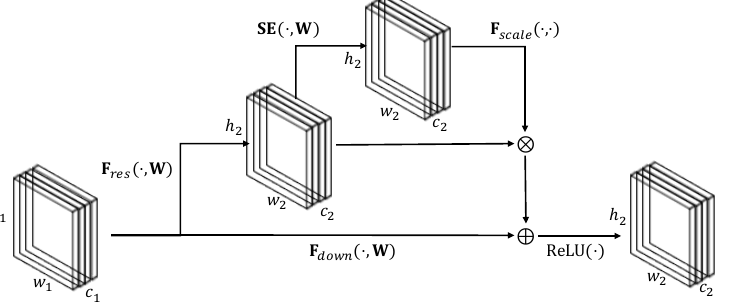
Figure 4. Residual Squeeze-and-Excitation block. After the residual block, the SE attention module is placed to weight enhance the feature representation.